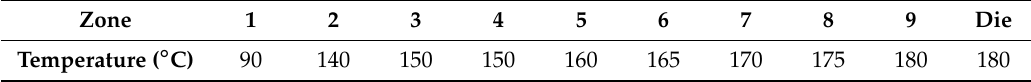
Table 2. Temperature profile used in the extrusion